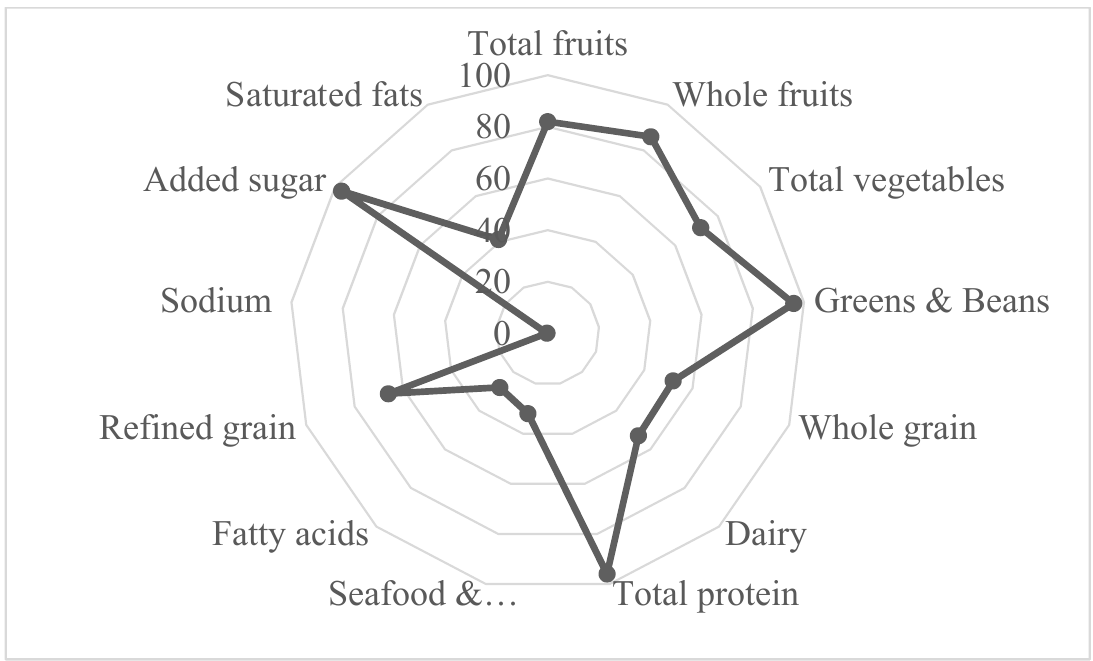
Figure 2. Spider plot indicating the percentage for each dietary component of HEI-2015 score before pregnancy ( n = 1936). Table 1. Characteristics of the ALSWH mothers and their children according to offspring BMI category ( n = 3391) a . All Children Offspring BMI Category Characteristics n = 3391 Underweight Normal Overweight Obese HEI-2015 score (%) of mothers 0.01Quartile